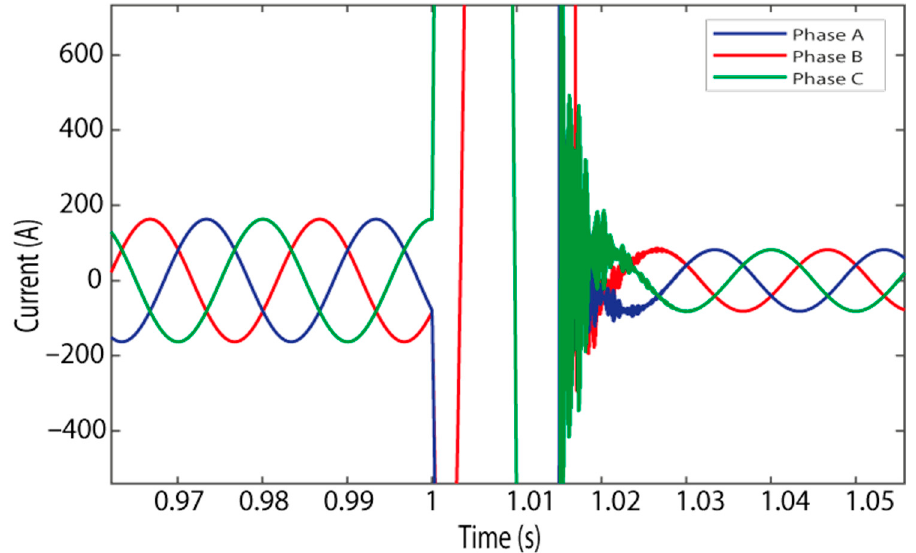
Figure 14. Three-phase current during the fault in line 3.